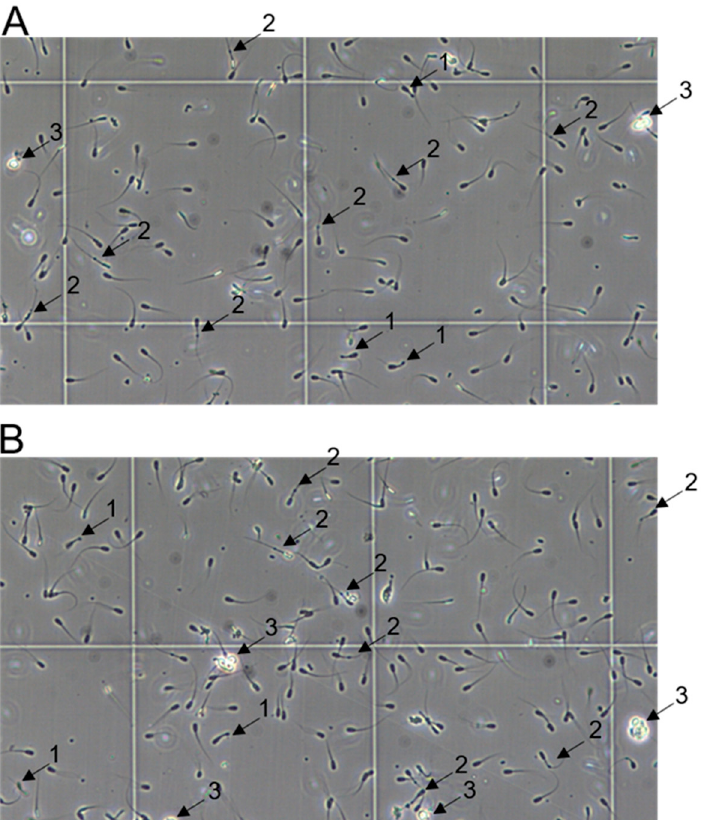
Figure 10. Representative sections of semen collected from boar #4 at 14 ( A ) and 20 ( B ) dpi. Abnor- mal spermatozoa with coiled tails (1), mobility-hampering formations at the tail (2), and round cells (3) are indicated with arrows. Viability of marked cells was validated by trypan blue staining.